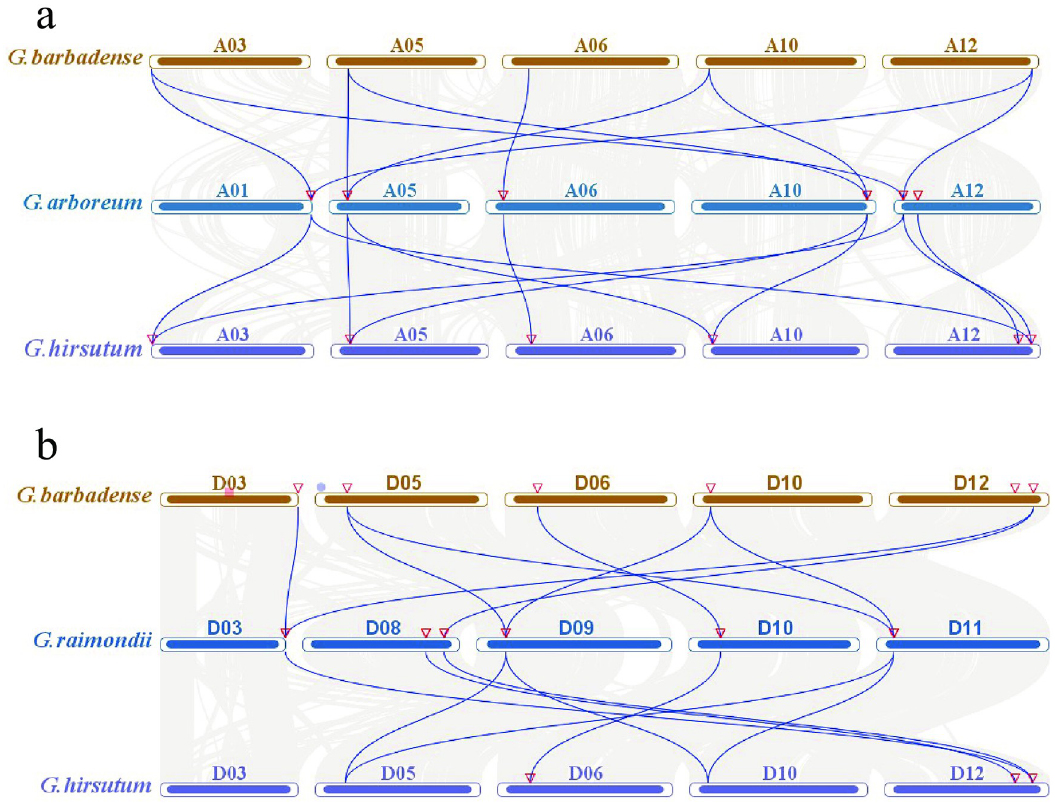
Fig 4. Collinearity of MIOX genes between different cotton species. (a) Collinearity between A-genome of G . arboretum and A- subgenome of G . hirsutum and G . barbadense ; (b) Collinearity between D-genome of G . raimondii and D-subgenome of G . hirsutum and G . barbadense